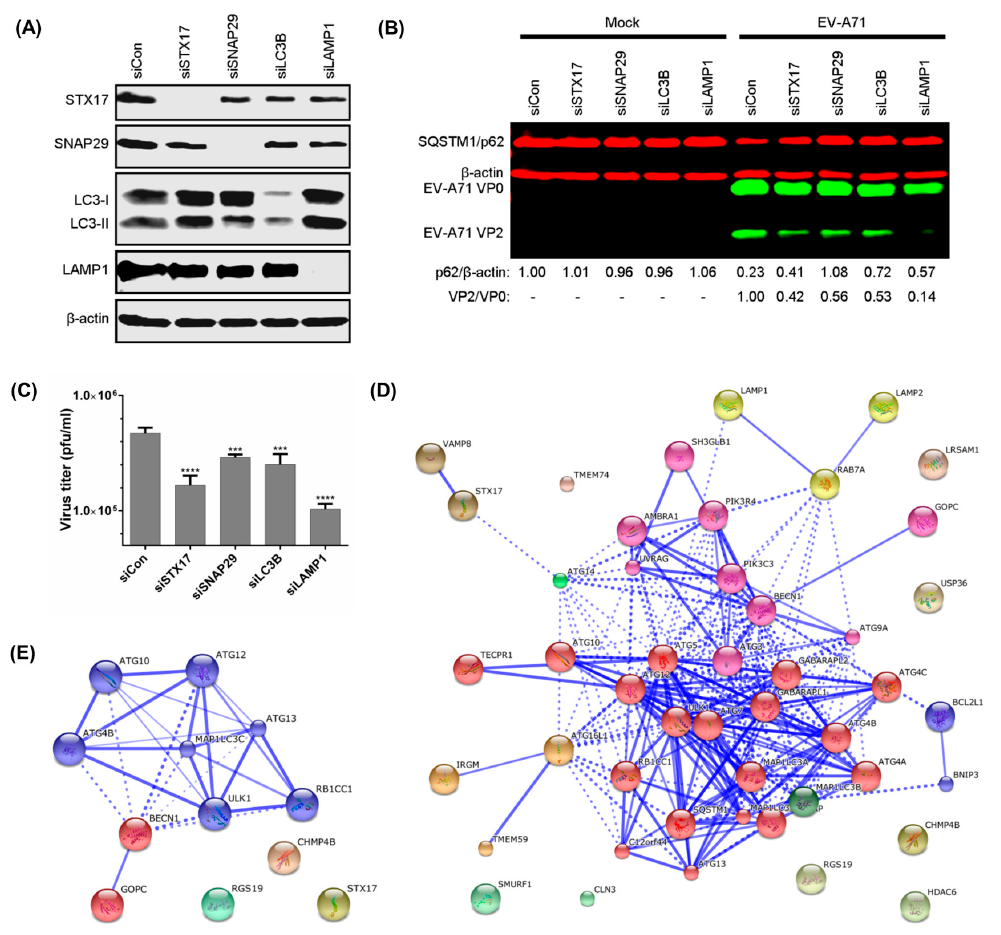
Figure 4. Transient knockdown of syntaxin-17 (STX17), synaptosome-associated protein of 29 kDa (SNAP29), LC3B, and lysosomal-associated membrane protein 1 (LAMP1) impairs production of infectious EV-A71. ( A ) RD cells were transfected with 40 nM of STX17, SNAP29, LC3B, LAMP1, or control pools of 3 siRNAs for 48 h, and endogenous proteins were detected by Western Blot (WB); ( B ) RD cells were transfected as in ( A ) and infected with EV-A71 (MOI = 10) for 8 hpi, and SQSTM1/p62 and viral proteins were detected by WB; ( C ) RD cells were transfected and infected as in ( B ) for plaque assay to determine viral titres; ( D ) Graphical presentation of the 47 autophagy-associated proteins considered in this study. These proteins were used in the yeast two-hybrid arrays against 2BC non-structural protein; ( E ) Graphical presentation of the 12 autophagy-associated proteins that interacted with 2BC non-structural protein of EV-A71. The Markov Cluster Algorithm was performed using STRING to cluster the autophagy-related proteins. The width of blue lines is proportional to the strength of interactions between proteins, with greater width indicating stronger interaction. The dashed lines indicate the possible interactions between proteins. One-way ANOVA: *** p < 0.001, and **** p <